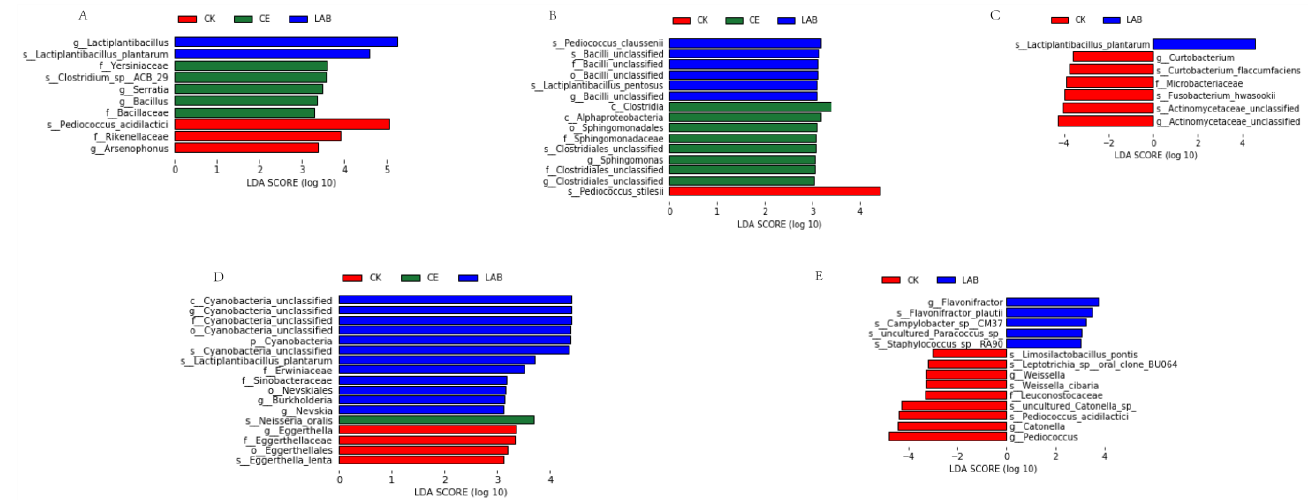
Figure 3. Identification of the communities that have significant differences among the three groups. CK, no additive control; CE, cellulase; LAB, lactic acid bacteria. Arabic number indicates days of ensiling. ( A ) after 3 d of ensiling; ( B ) after 7 d of ensiling; ( C ) after 15 d of ensiling; ( D ) after 30 d of ensiling; ( E ) after 60 d of ensiling.